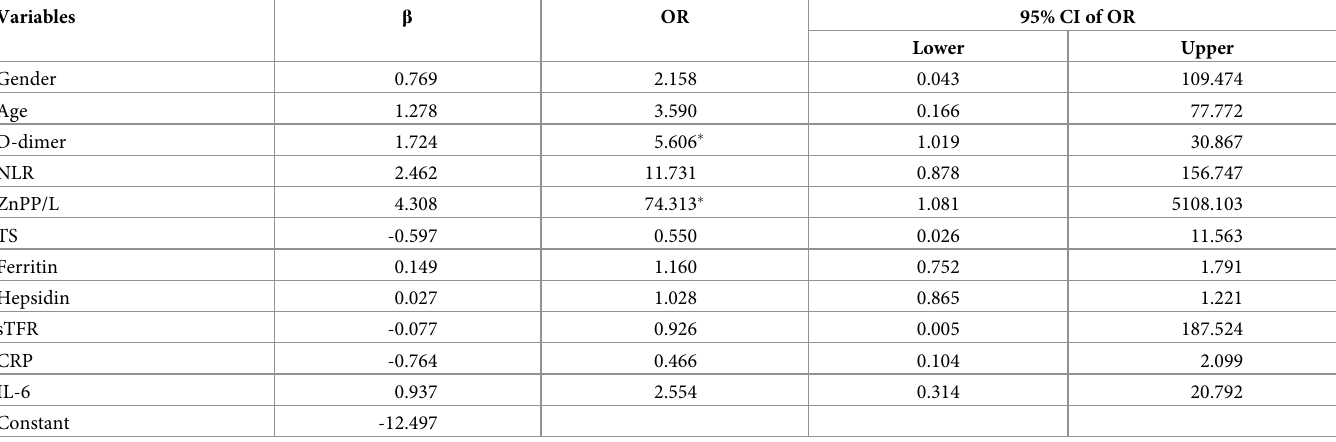
Table 6. Logistic regression analysis for single predictors associated with COVID-19 severity.